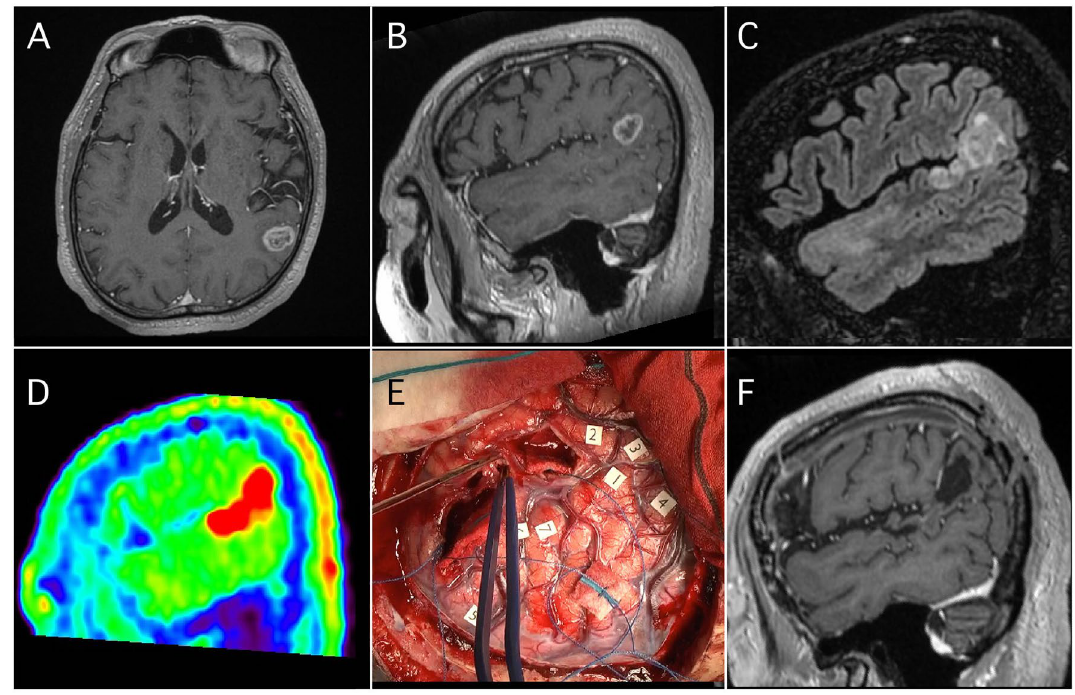
Figure 2. Illustrative case of supratotal resection with Met-PET. A contrast-enhanced tumor was observed in the left supramarginal gyrus ( A , B ). The abnormal FLAIR area was larger than the contrast-enhanced area ( C ), but smaller than the area of Met uptake ( D ) extending along the superior temporal gyrus. Supratotal resection of both the contrast-enhanced and area of Met uptake was achieved under awake cortical and subcortical mapping ( E ). At final follow-up imaging, neither LR nor DR was apparent ( F